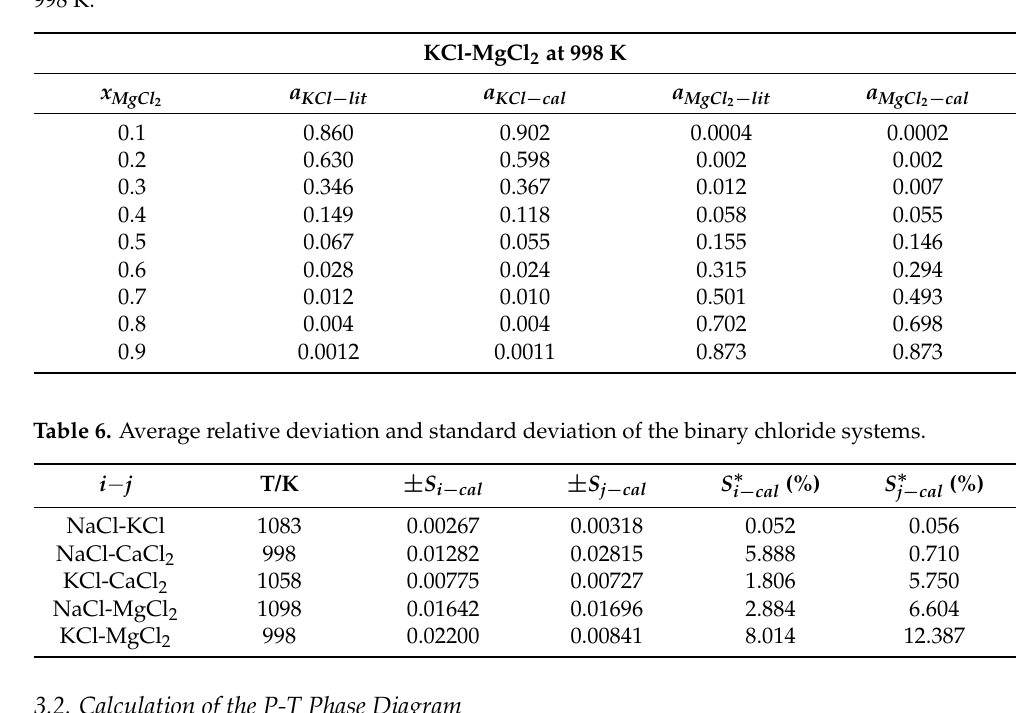
Table 5. Calculated activity values and literature data of the KCl-MgCl 2 binary chloride system at